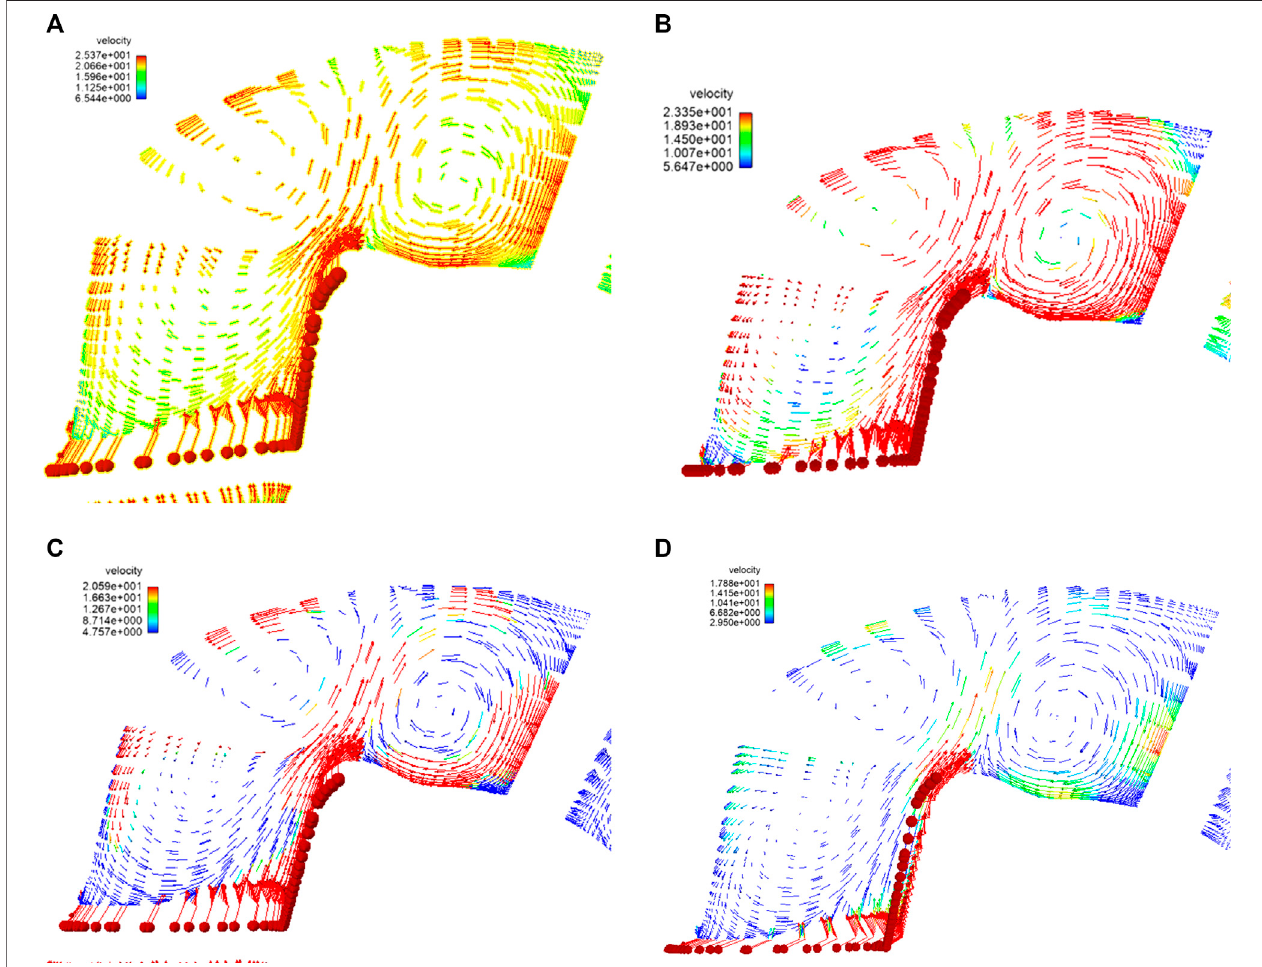
FIGURE 5 | Distribution of the secondary fl ow in the link between the impeller and space guide vane: (A) 1,100 rpm, (B) 1,200 rpm, (C) 1,300 rpm, and (D) 1,450 rpm.